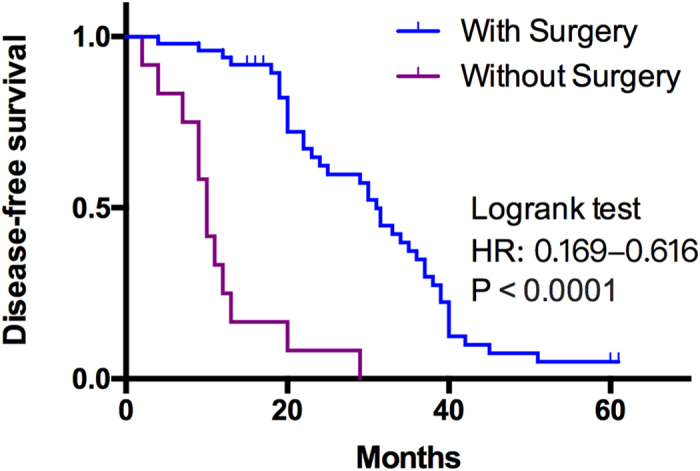
Survival curves according to surgery and without surgery.